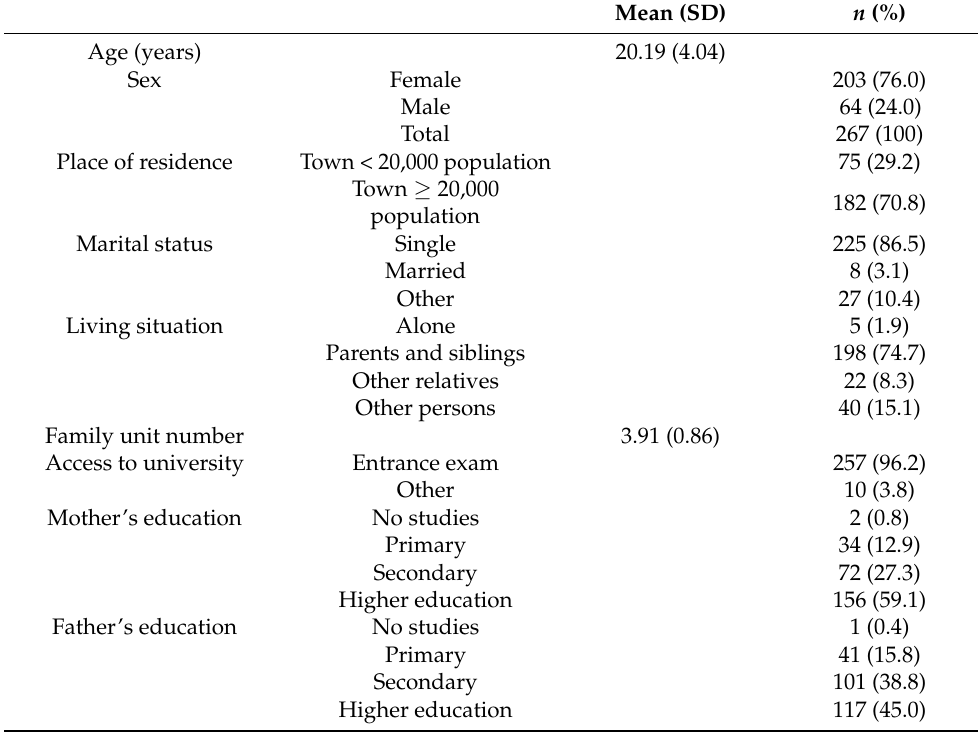
Table 1. Participant characteristics.